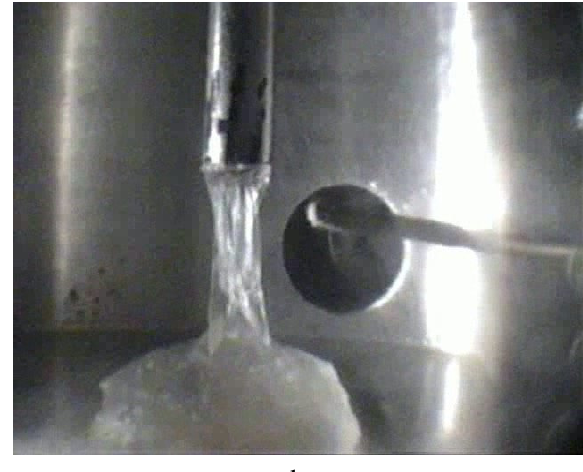
Figure 7. (a) Hydrate rapidly forming as droplet expands; (b) a conduit made of hydrate allowing water flow to the bottom of the